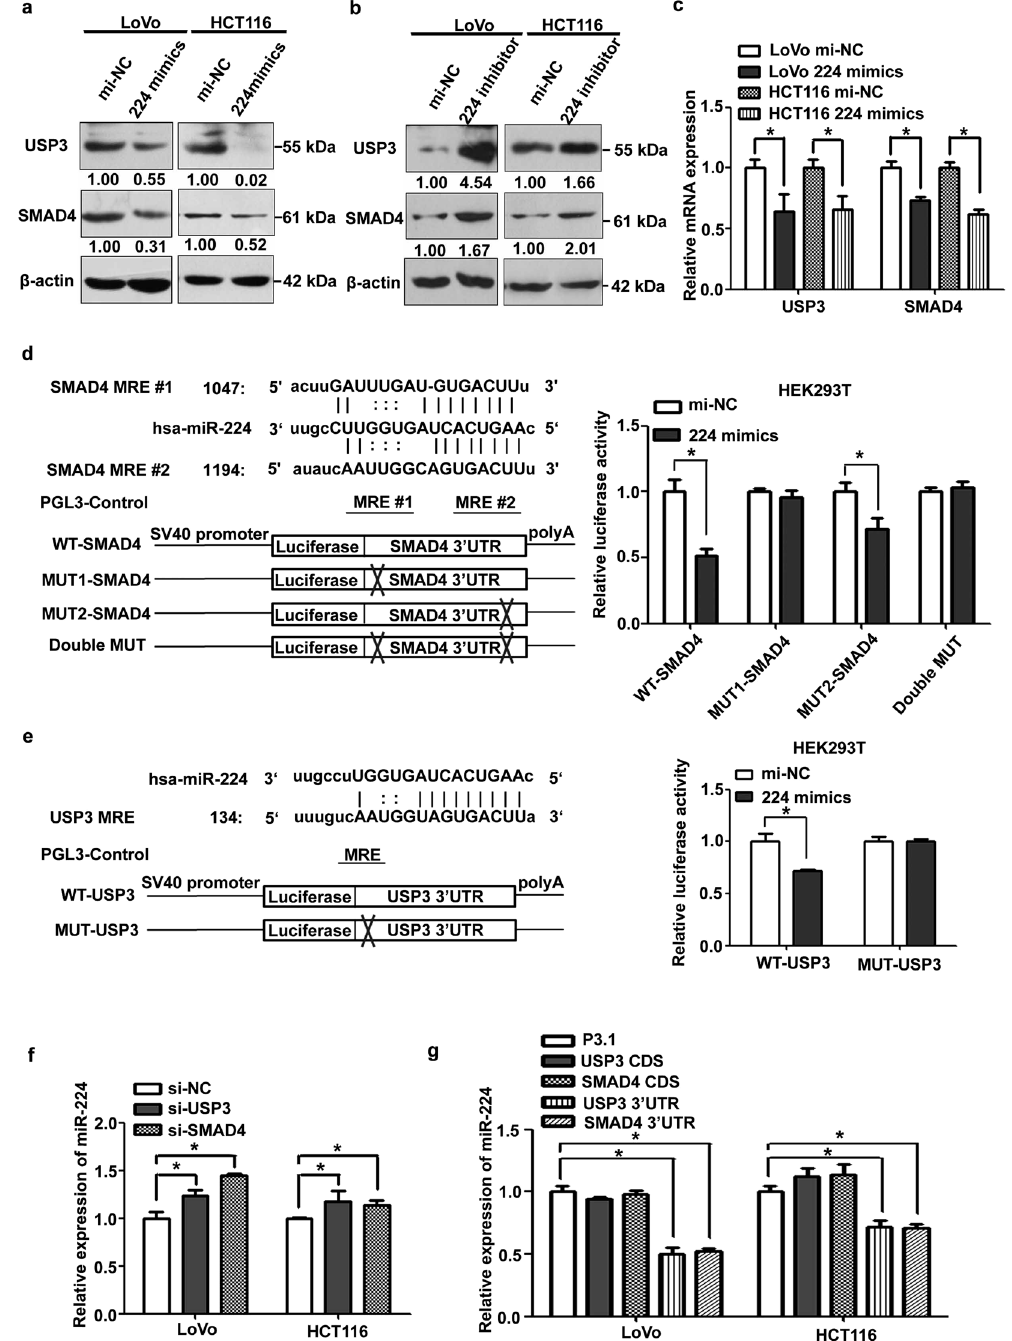
Figure 3. miR-224 modulated expression of USP3 and SMAD4. ( a ) miR-224 mimics attenuated protein expression of USP3 and SMAD4 and ( b ) miR-224 inhibitor enhanced USP3 and SMAD4 expression. Western blots are cropped; full-length blots are included in Supplementary Figures S15 and S16. The results were quantified by ImageJ software, and the relative protein ratio was normalized to β -actin. ( c ) Expression of USP3 and SMAD4 mRNA were reduced by miR-224 mimics in LoVo and HCT116 cells. ( d,e ) Left upper panel: Schematic diagram of miR-224-binding sites in the SMAD4 or the USP3 3 ′ UTRs from microRNA.org. Left lower panel: Construction of USP3 or SMAD4 luciferase reporter plasmids containing wild-type miR-224 MREs (WT) or mutant sequences (MUT). Right panel: Luciferase reporters harbouring wild-type or mutant miR-224-binding sites of the USP3/SMAD4 3 ′ UTR were co-transfected with miR-224 mimics/mi-NC. Relative luciferase activity is presented as the mean ± SD (n = 3). ( f,g ) miR-224 expression was determined by qRT-PCR after USP3/SMAD4 silencing or USP3/SMAD4 CDS or 3 ′ UTR overexpression in CRC cells. * P <